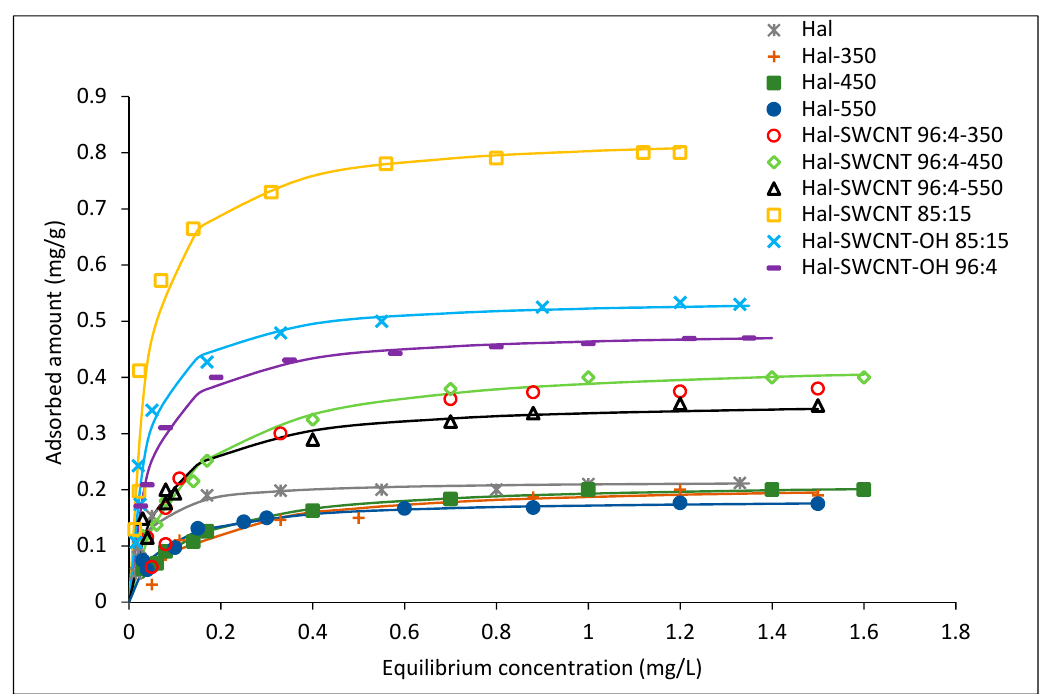
Figure 6. Langmuir adsorption isotherms of anthracene on Hal, Hal-350, Hal-450, Hal-550 and Hal-CNT composites. The solid line represents the Langmuir fitting.